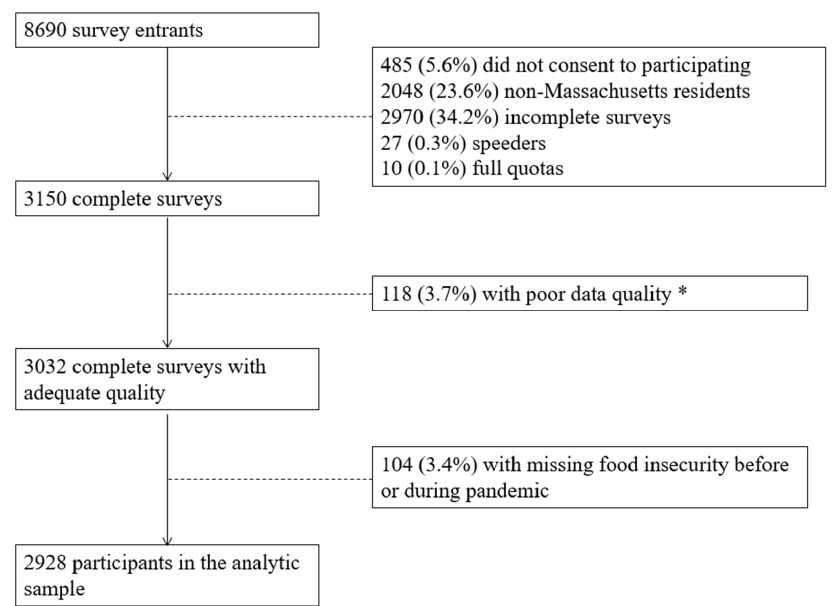
Figure A1. Study flow diagram. * Poor data quality was defined as having non-sensical free-text responses, age below 18 or above 100, survey response information which differed greatly from the Qualtrics demographic information, or more than two data flags (e.g., respondent’s age does not